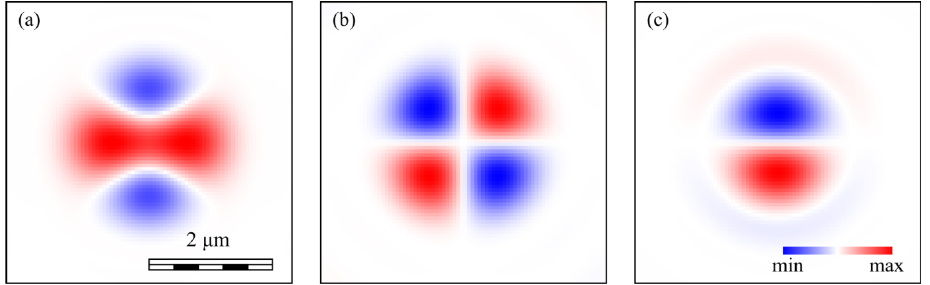
Figure 14. Components of the Stokes vector computed by the Richards-Wolf formulae: s1 ( a ), s2 ( b ) and s3 ( c ).